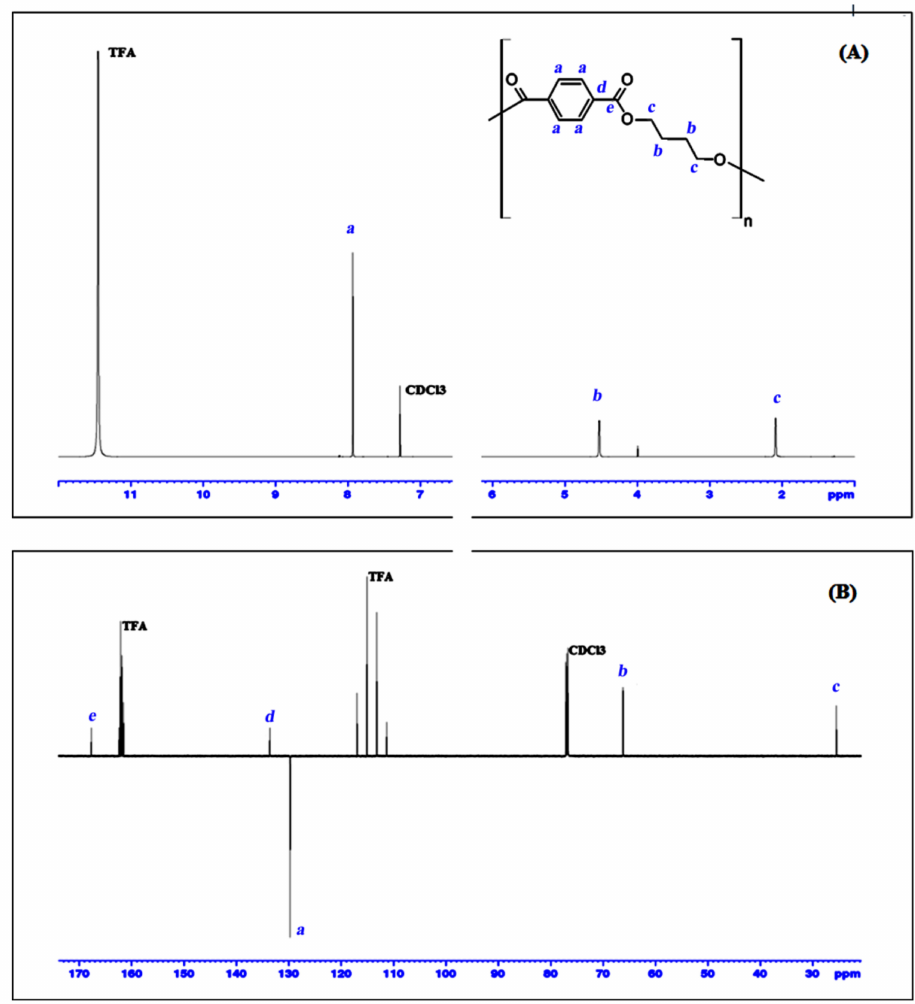
Figure 6. 1 H NMR spectrum ( A ) and 13 C APT NMR spectrum ( B ) of the PBT cyclic dimer, with signals assigned to corresponding atom’s position in the molecule (a, b, c, d, e), recorded in CDCl 3